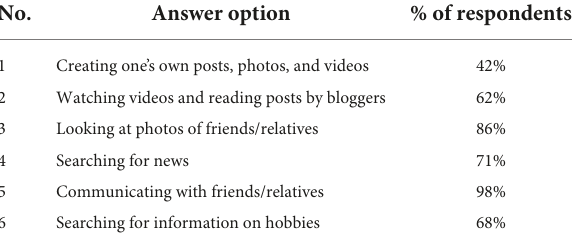
TABLE 1 The main reasons to use social networking sites.